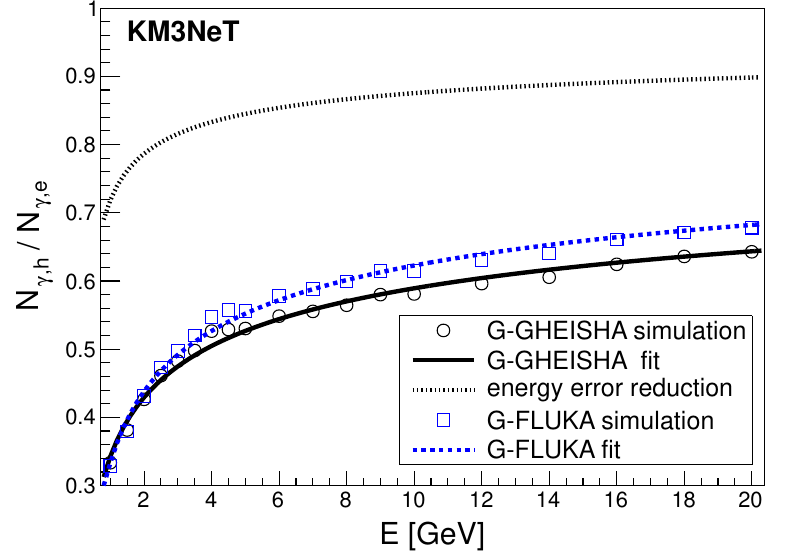
Figure 4 . Number of photons emitted in the case of a hadronic cascade N (cid:13);h relative to an electromagnetic cascade N (cid:13);e of the same energy, showing data points and the (cid:12)tted function (eq. (3.1)). Cascades simulated with G-GHEISHA ( G-FLUKA ) are shown in black (blue). Also